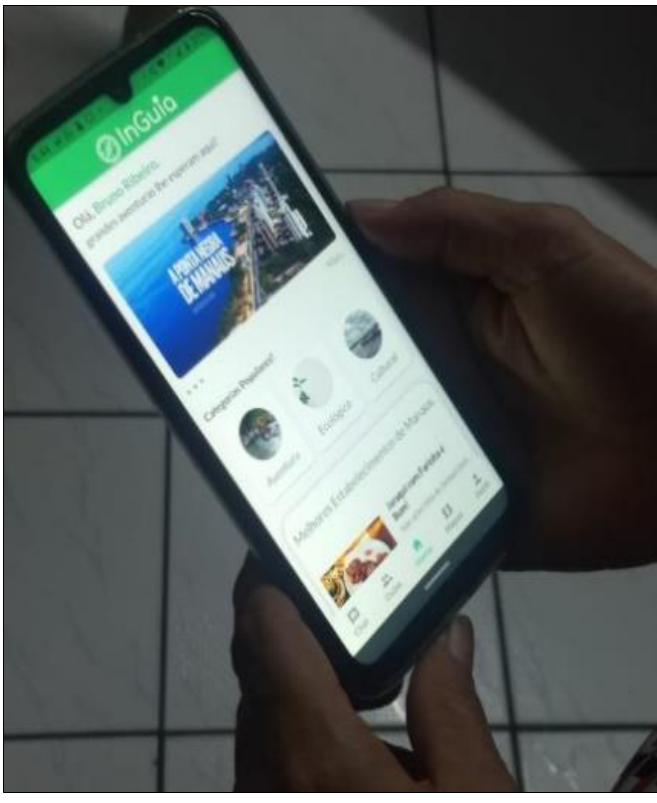
Figure 2: Usability test, home.